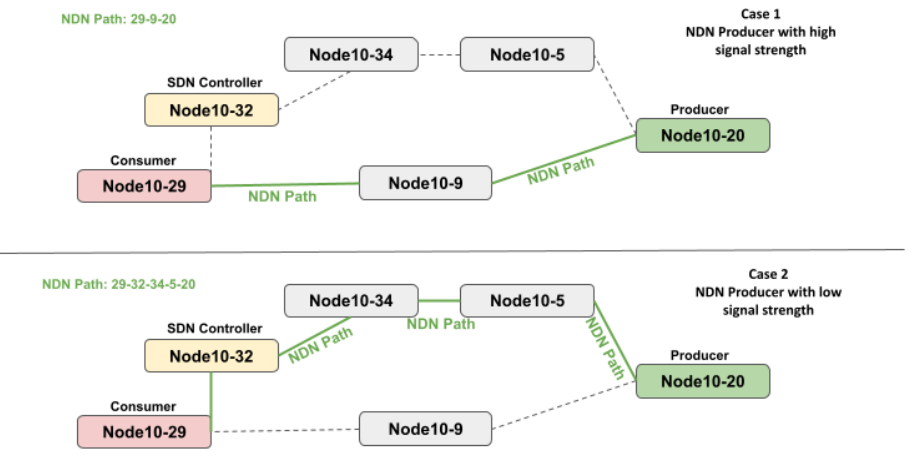
Figure 8. WMN topology, considering the 10th floor of the w-iLab.1